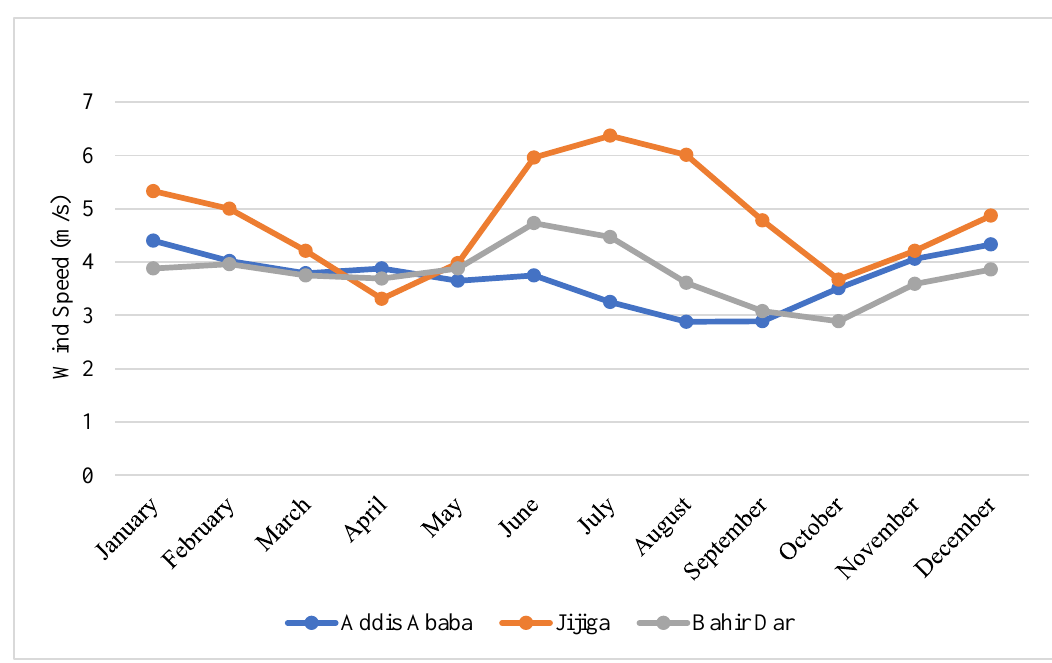
Figure 3. Monthly average wind velocity of cities.